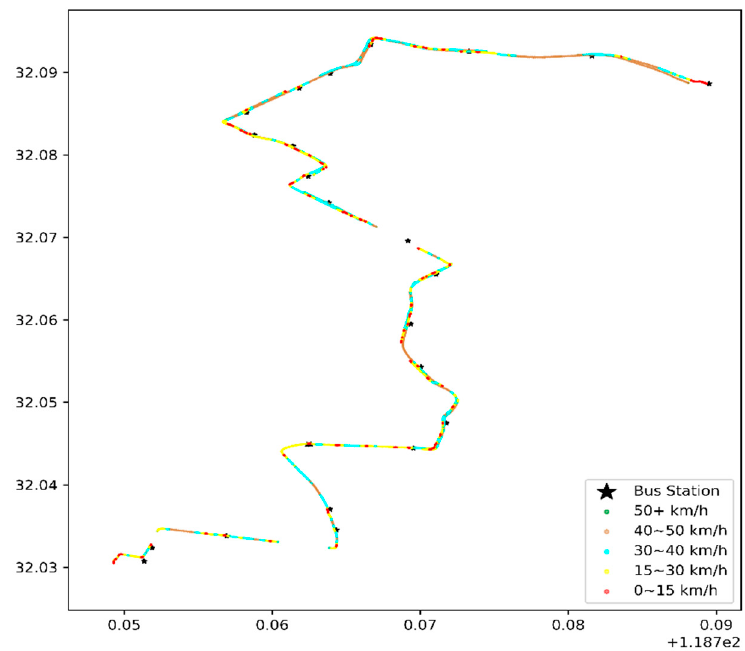
Figure 8. Heat map of the vehicle speed of the first bus in the early morning, with the coordinates of the x-axis longitude ( ◦ E) and latitude ( ◦ N) on 1 January 2016.